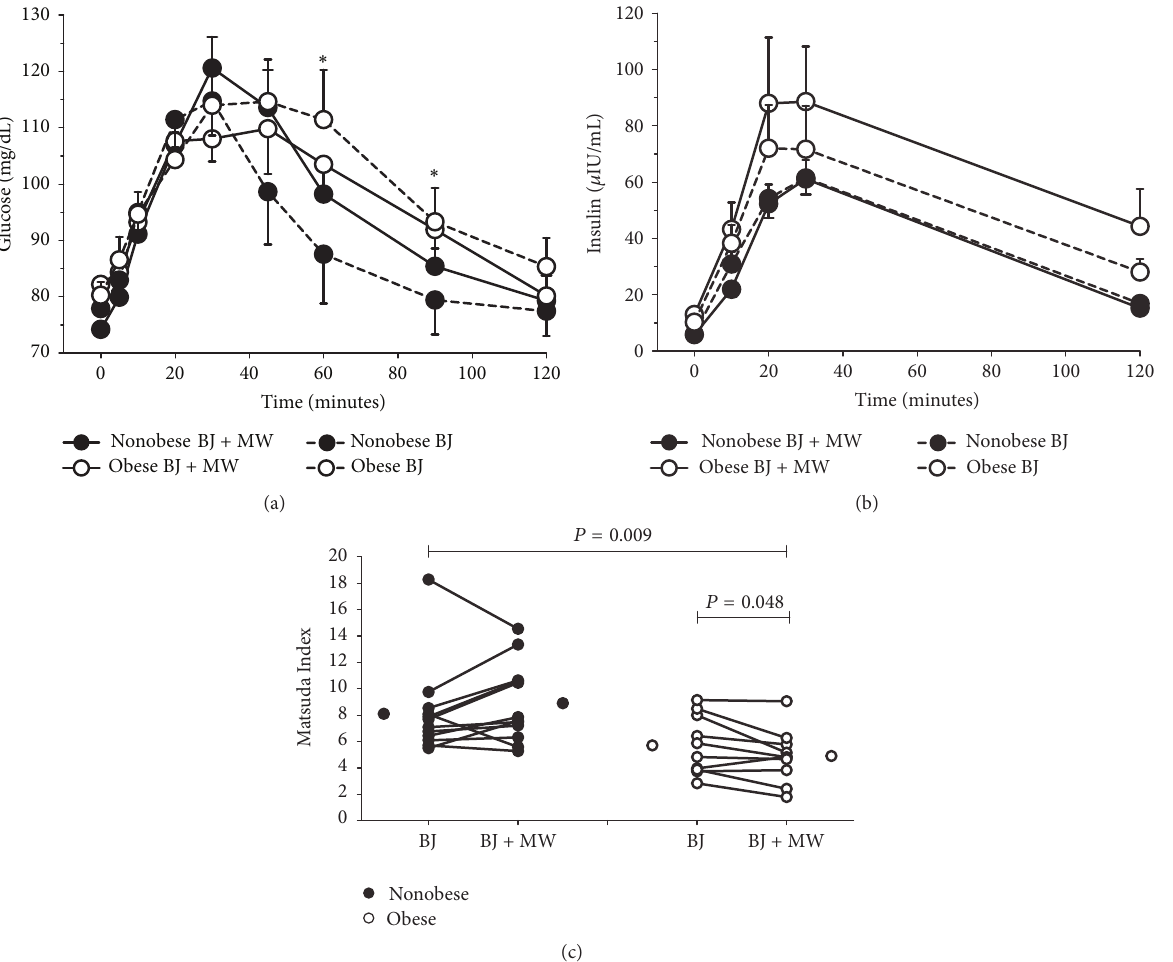
Figure 2: Blood glucose concentration after beet juice plus glucose consumption was greater in the obese compared with the nonobese adults at 60 and 90 minutes ( 𝑃 = 0.004 and denoted by ∗ ). Inhibition of oral bacteria nitrate reductase activity with mouthwash did not influence blood glucose or insulin in either group ( 𝑃 > 0.08 ). Insulin sensitivity, as represented by the Matsuda Index (where a higher value is reflective of greater insulin sensitivity), was lower in obese adults compared with nonobese adults ( 𝑃 = 0.009 ). Inhibition of oral bacteria nitrate reductase activity with mouthwash decreased insulin sensitivity in obese adults but not in nonobese adults ( 𝑃 = 0.048 ). Glucose and insulin: data are mean and standard error. Matsuda Index: lines represent individual responses; stand-alone circles represent mean values.